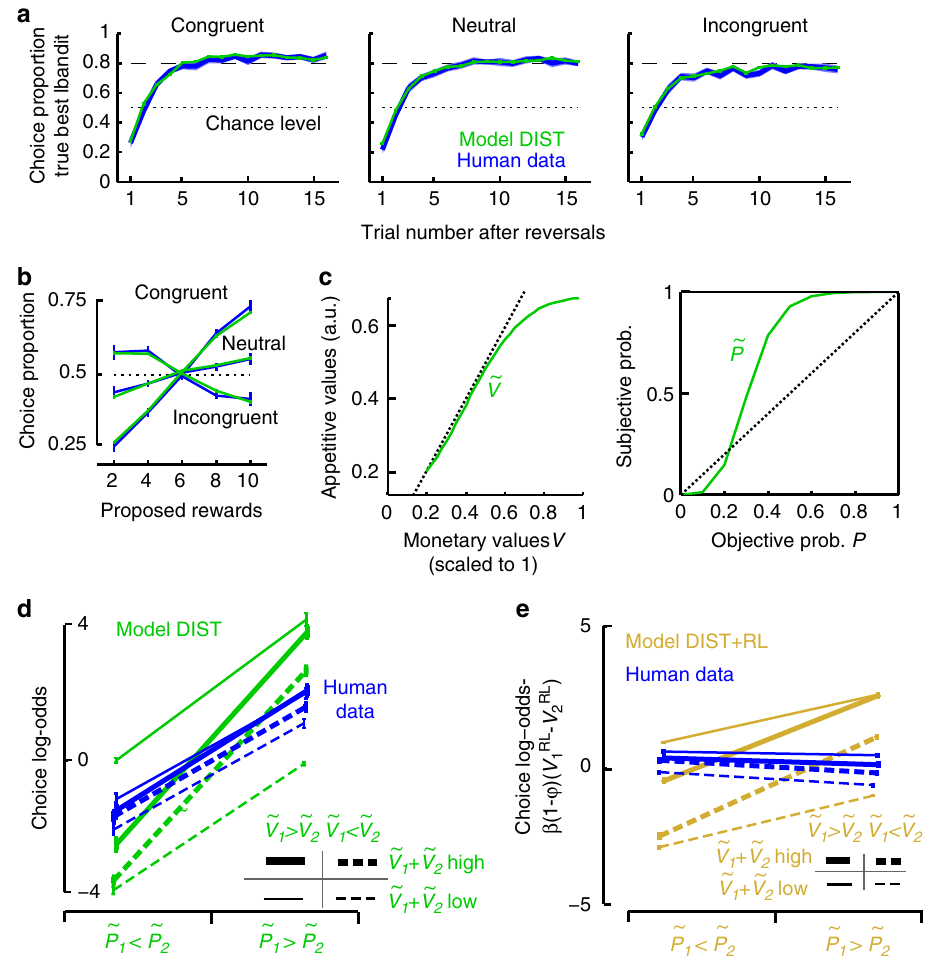
Fig. 2 Model DIST fi t to human performances. a Proportions of choosing true best bandits (maximising reward frequencies x proposed rewards) following reversals. b Proportions of choosing proposed rewards. In a and b , mean proportions are shown in the congruent, neutral and incongruent condition for fi tted model DIST (green) and participants (blue, ±s.e.m.). See Supplementary Fig. 1 for (parameterised) model OPT fi t. c Appetitive values of proposed monetary rewards ~ V (left) and subjective probabilities in inferred bandits ’ reward probabilities ~ P (right) in model DIST fi tting human choices (lines correspond to distortion functions with mean parameters over participants). d Factorial analysis of choice log-odds over trials sorted according to (cid:4) subjective probabilities ~ P 1 > ~ P 2 vs : ~ P 1 < ~ P 2